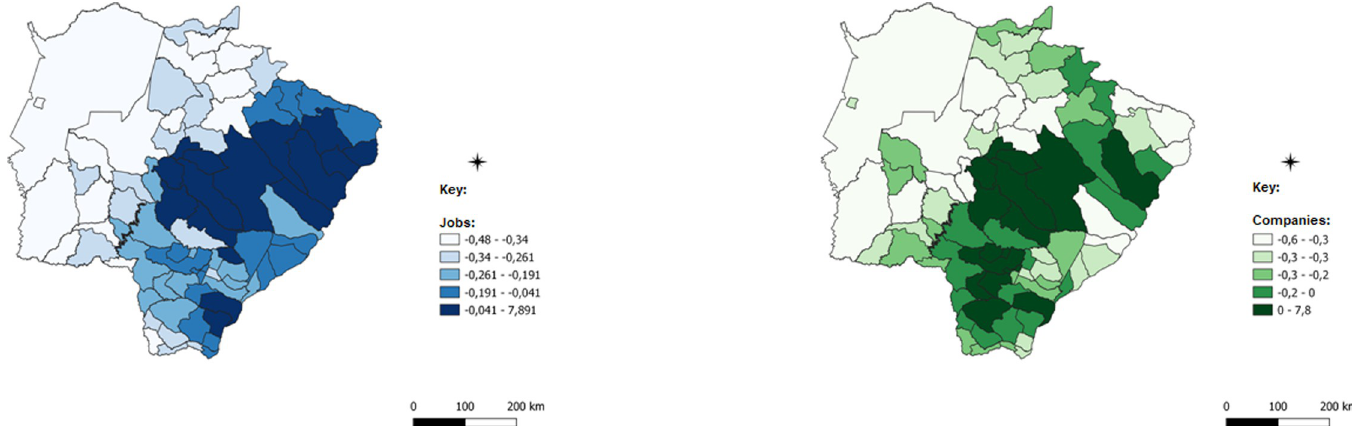
Fig 7. Spatially weighted Compound Concentration Index of civil construction. Caption credit: Elaborated from secondary data extracted from [26].